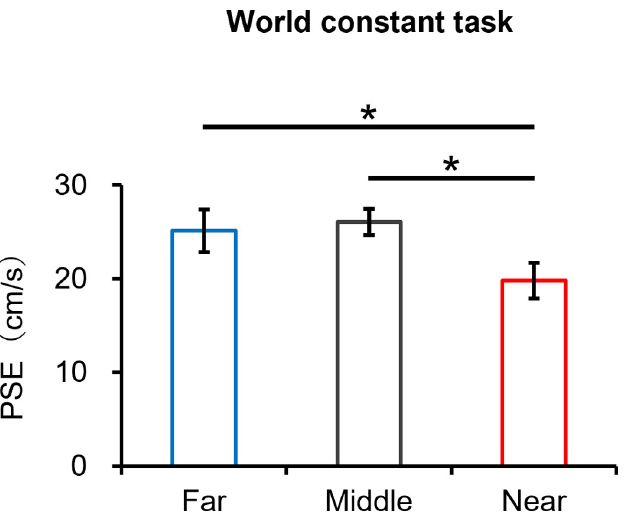
Fig 5. The comparison of the PSE between the far, middle and near conditions in the world constant task. Error bars indicate the standard deviation. � : p < 0.05.